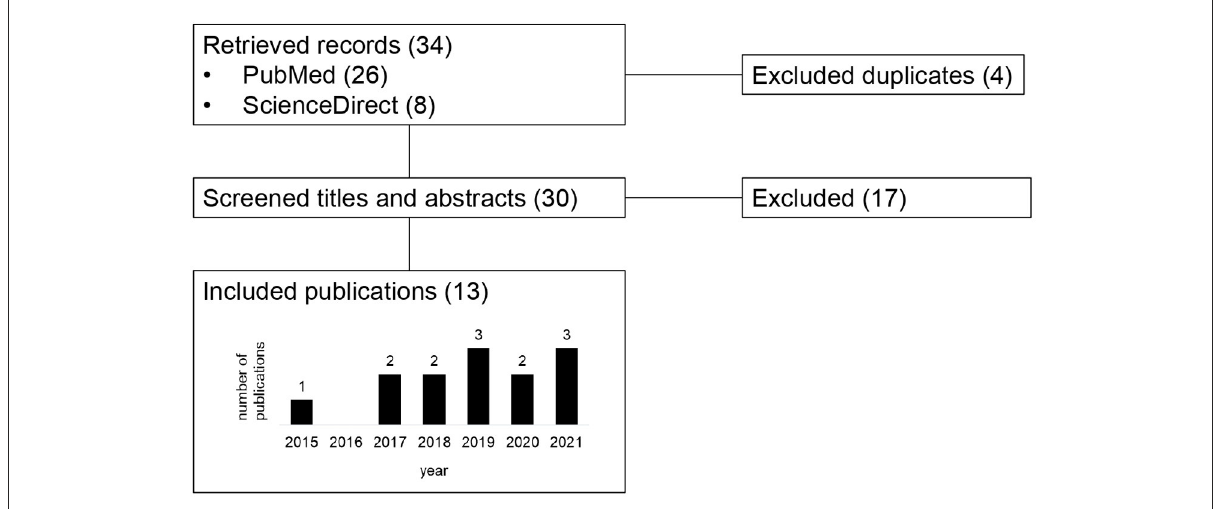
FIGURE1 Flow diagram of retrieved, excluded and included records, by publication